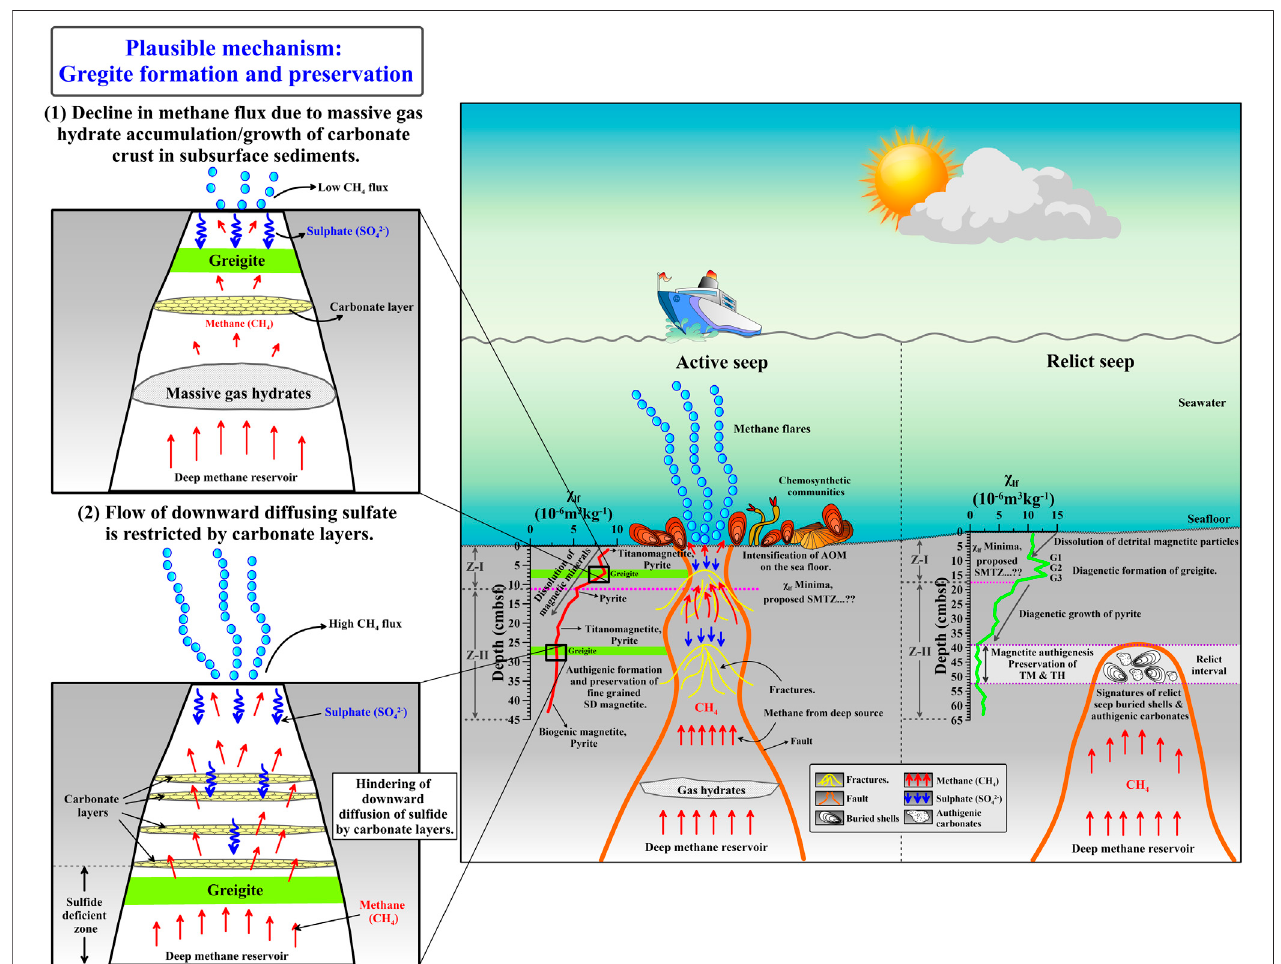
FIGURE14| Conceptual modelexplainingthestructuraland diageneticcontrolsontheevolutionofmagneticmineralogiesatactiveand relictmethaneseepsitein the Krishna-Godavari (K-G) basin, Bay of Bengal.